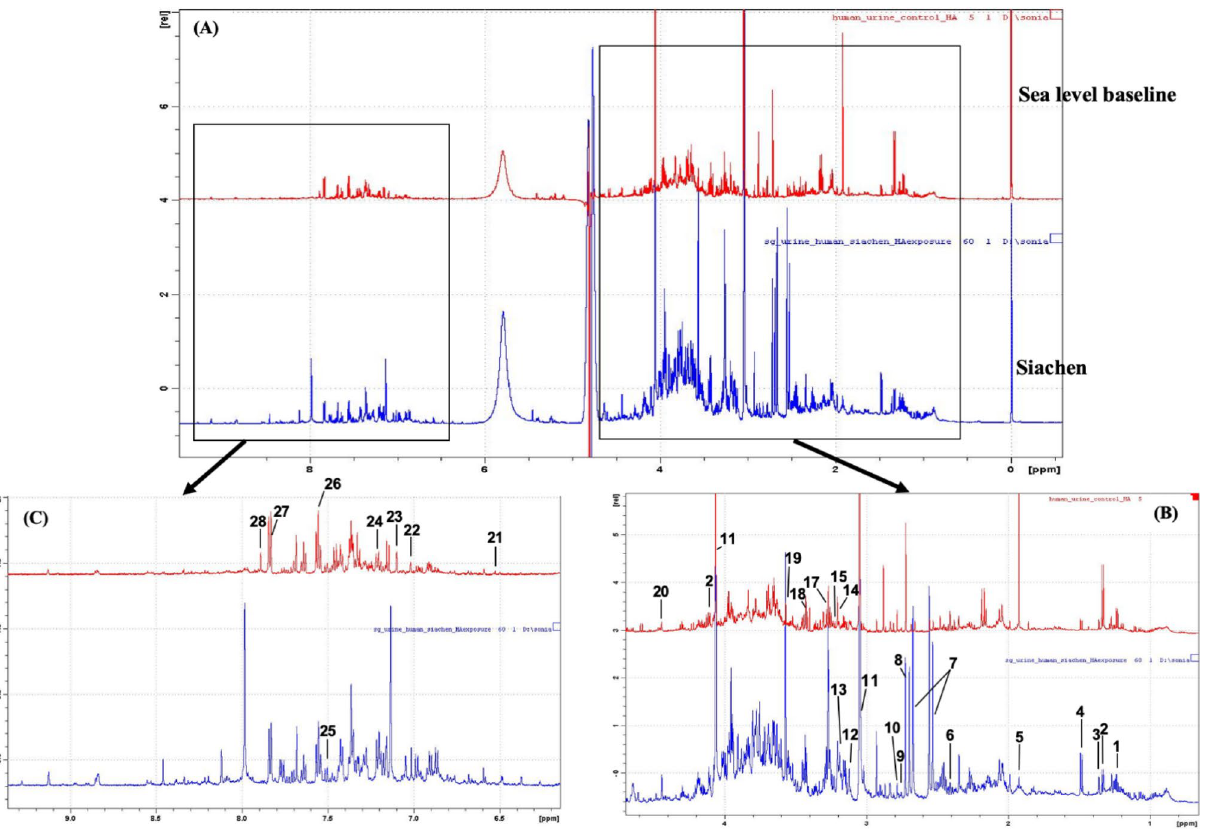
Figure 2. Representative 1H-NMR spectra ( A ) δ 0–δ 10.0 ( B ) δ 0.5–δ 4.5 ( C ) δ 6.5–δ 9.5, of urine samples from sea level baseline group and Siachen group. The labelled metabolites are: 1. Isoleucine, 2. Lactate, 3. Hydroxybutyrate, 4. Alanine, 5. Acetate, 6. Succinate, 7. Citrate, 8. Dimethylamine, 9. Sarcosine, 10. Dimethylglycine, 11. Creatinine, 12. Cysteine, 13. Cisaconitate, 14. Tyrosine, 15. Choline, 17. TMAO, 18. Acetoacetate, 19. Glycine, 20. NMN, 21. Fumarate, 22. Dihydroxymandalate, 23. Methylhistidine, 24. Tyrosine, 25. Indoxylsulphate, 26. Phenylalanine, 27. Hippurate, 28.